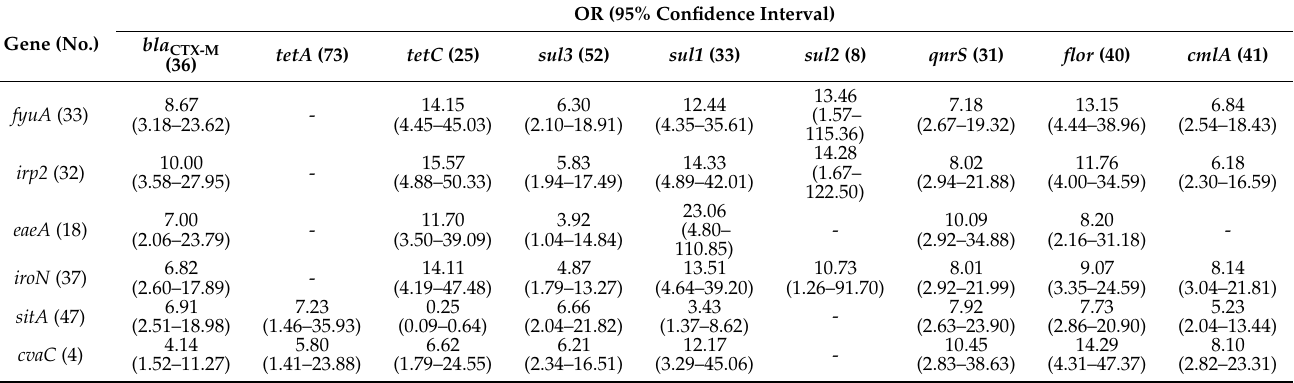
Table 5. Odds ratios (OR) of antibiotic resistance genes associated with virulence-associated genes in E. coli isolates from captive giant pandas (n =